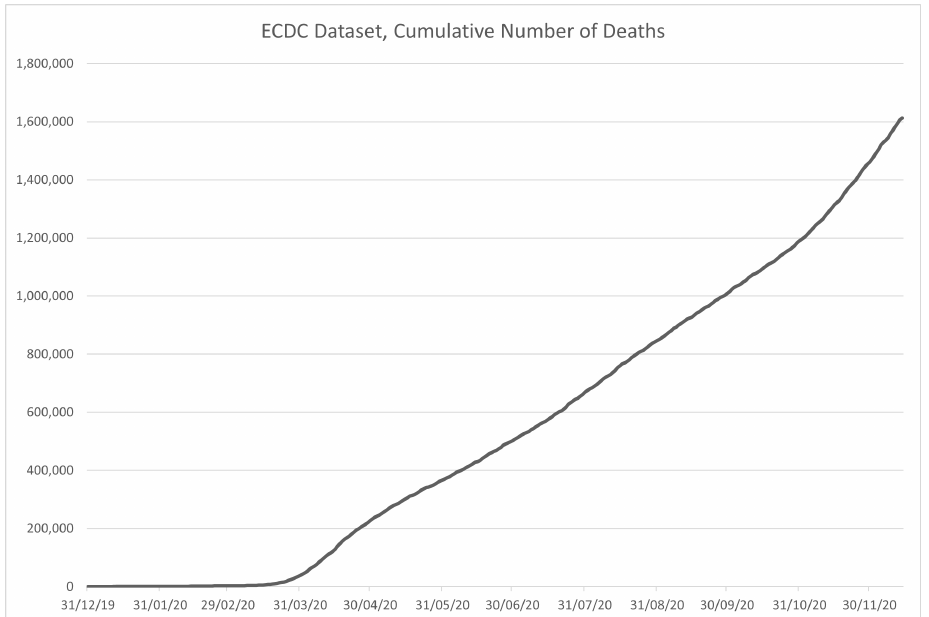
Figure 8. Time-series plot of the data in the ECDC dataset, for deceased patients, contained within the